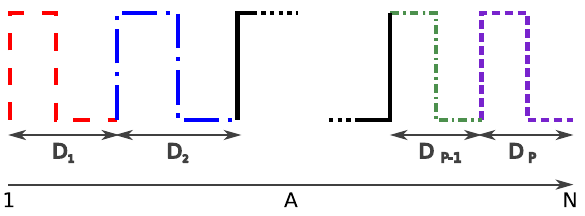
Figure 8. Example of a binary vector A for the inhalation–exhalation cycle. D x corresponds to the distance (number of frames) computed from an inhalation–exhalation cycle. Each line shape and color represents a different inhalation–exhalation